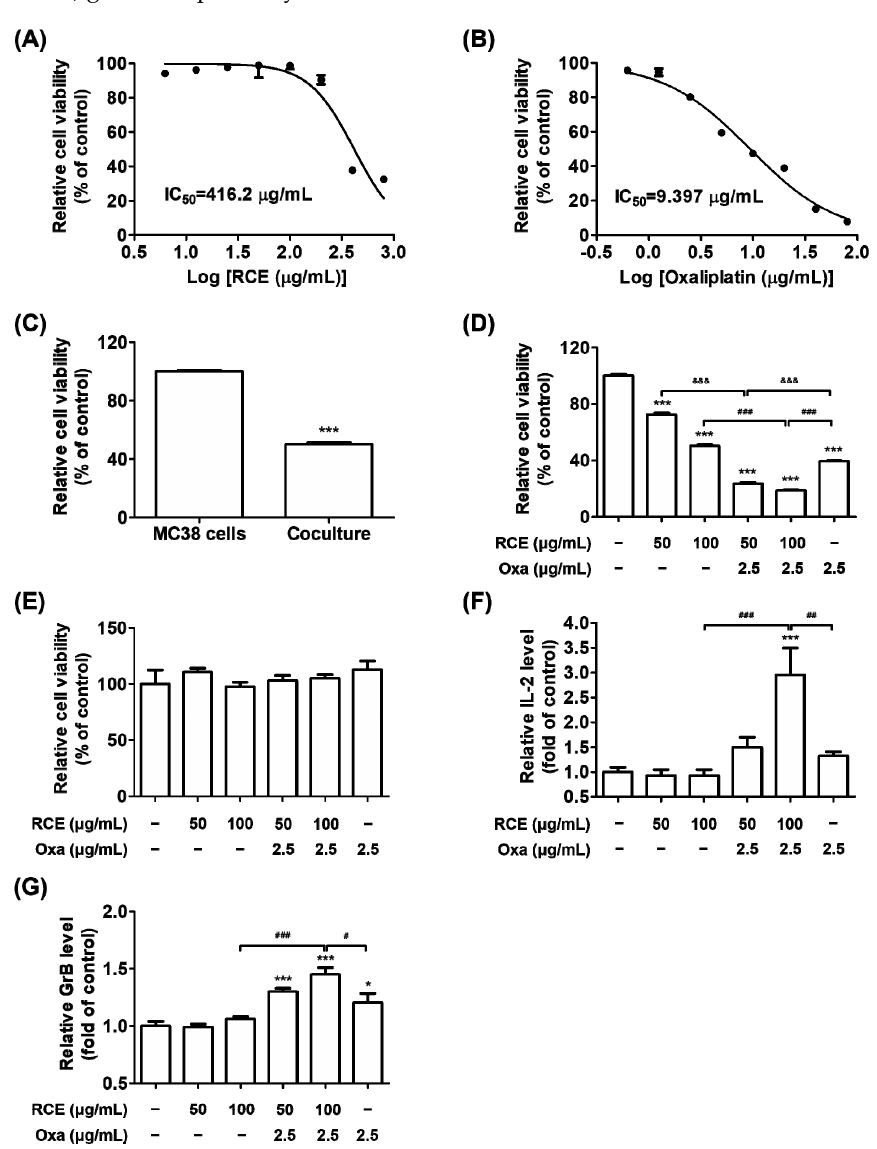
Figure 1. Antiproliferative effect of RCE plus Oxa on the co-culture of hPD-1 tumor-infiltrating CD3 + T cells and hPD-L1 MC38 cells. ( A , B ) The IC 50 value of hPD-L1 MC38 cells was determined by the CCK assay treated with various concentrations of RCE ( A ) or Oxa ( B ) for 72 h. ( C – G ) After 3 days of co-culture, hPD-L1 MC38 cells strongly interacted with tumor-infiltrating CD3 + T cells in the plate. The hPD-L1 MC38 cells co-cultured with hPD-1 tumor-infiltrating CD3 + T cells with effector- to-target ratios of 5:1 for 72 h. ( C ) The relative viability of hPD-L1 MC38 cells co-cultured with or without tumor-infiltrating CD3 + T cells was conducted using the CCK assay. ( D ) The viability of hPD-L1 MC38 cells co-cultured with tumor-infiltrating CD3 + T cells was evaluated using the CCK assay in the Oxa alone (2.5 μ g/mL), RCE alone (50, 100 μ g/mL), and in the RCE plus Oxa groups. ( E ) The viability of tumor-infiltrating CD3 + cells alone was evaluated using the CCK assay of treatment with Oxa alone, RCE alone, and RCE plus Oxa for 72 h and was not affected. ( F ) Relative IL-2 level in the co-culture supernatants for 24 h was measured by mouse IL-2 ELISA. ( G ) Relative GrB level in the co-culture supernatants for 72 h was quantified by mouse GrB ELISA. Results are presented as the mean ± SD. * p < 0.05 and *** p < 0.001 compared to the control, # p < 0.05, ## p < 0.01, ### p < 0.001, and &&& p < 0.001 compared to the individual group.